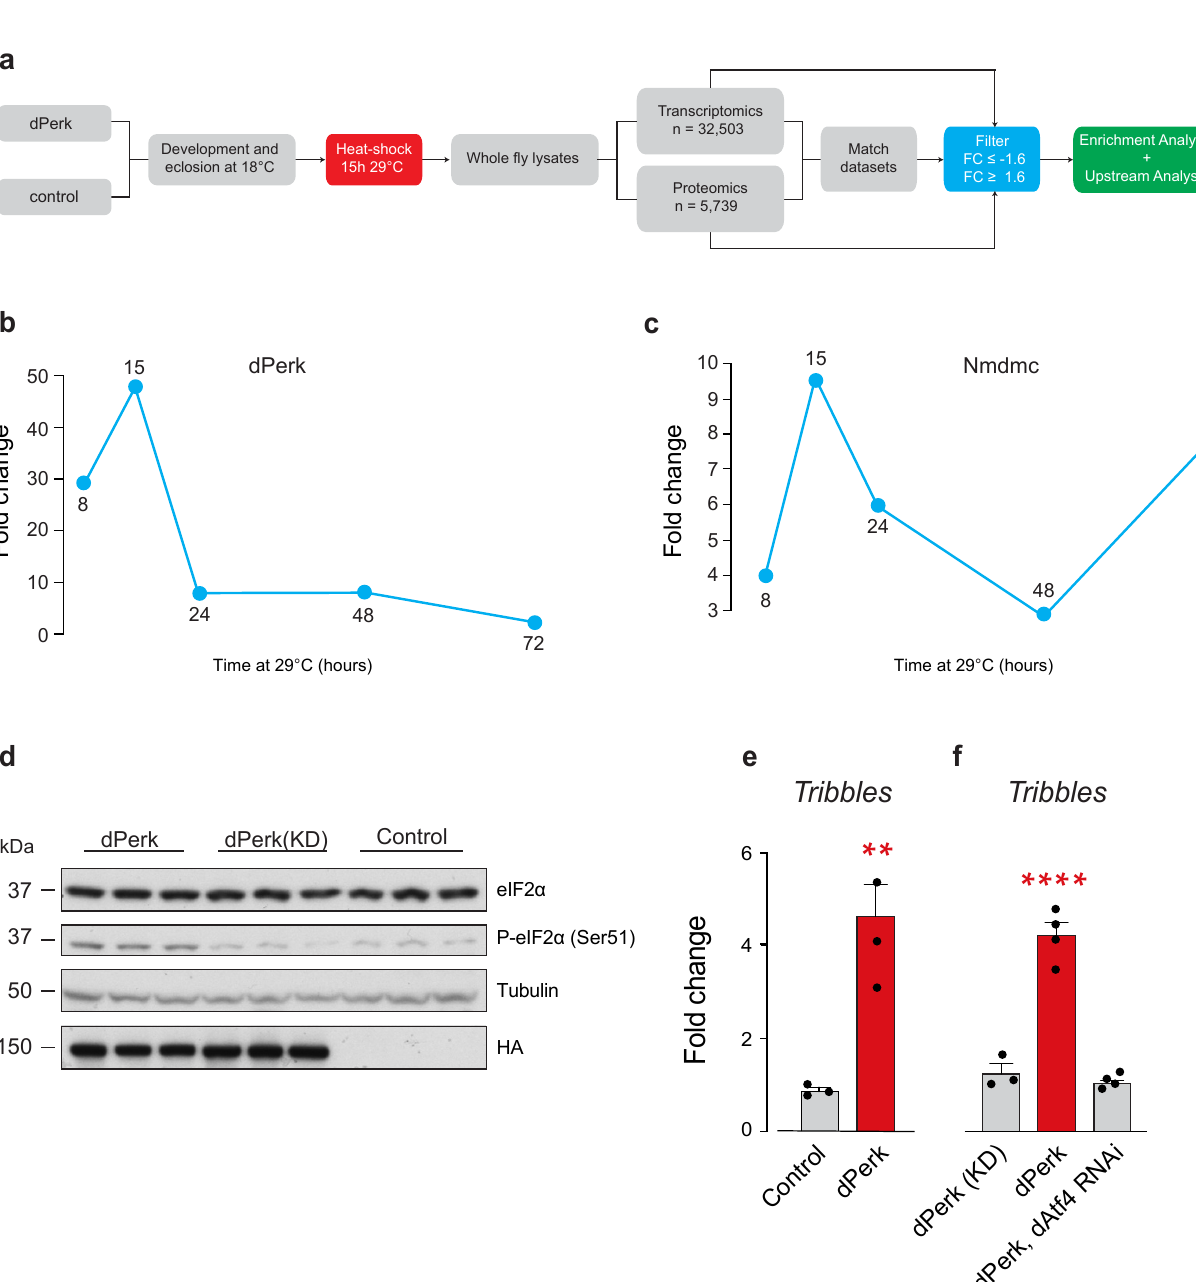
Figure 1. Drosophila dPerk regulates tribbles mRNA levels. ( a ) Workflow used for the characterisation of dPerk-dependent transcripts and proteins. To identify differentially expressed targets, transcripts and proteins were filtered by adjusted false discovery rate (FDR) and fold change (FC) values of 0.05 and ± 1.6, respectively. The expression levels of transcripts and proteins were compared and further submitted for enrichment and upstream analysis. ( b , c ) dPerk or Nmdmc mRNA induction were assessed for different durations of the heat shock treatment (in hours (h)). The figure shows fold-change mRNA levels compared to the control, measured by real-time qPCR. ( d ) Western blot analysis of total and phospho-eIF2 α protein levels in dPerk-HA, kinase-dead dPerk (KD)-HA and control flies following 15 h heat-shock at 29 ◦ C. Whole-fly lysates were analysed using the indicated antibodies. ( e ) Tribbles ( trbl ), an endoplasmic reticulum stress marker, was upregulated in dPerk flies following 15 h of heat shock, as measured by real-time qPCR (mean ± SEM; asterisks, unpaired t -test). ( f ) Trbl overexpression is dAtf4 dependent and requires dPerk kinase function (15 h heat shock at 29 ◦ C), as measured by real-time qPCR (mean ± SEM; asterisks, one-way ANOVA with Tukey’s multiple comparison test). Genotypes: Control: tub Gal80; da Gal4 > +, dPerk: t ub Gal80; da Gal4 > dPerk -HA, dPerk(KD): t ub Gal80; da Gal4 > dPerk -K671R-HA, dPerk, dAtf4 RNAi: tub Gal80; da Gal4 > d Perk -HA, dAtf4